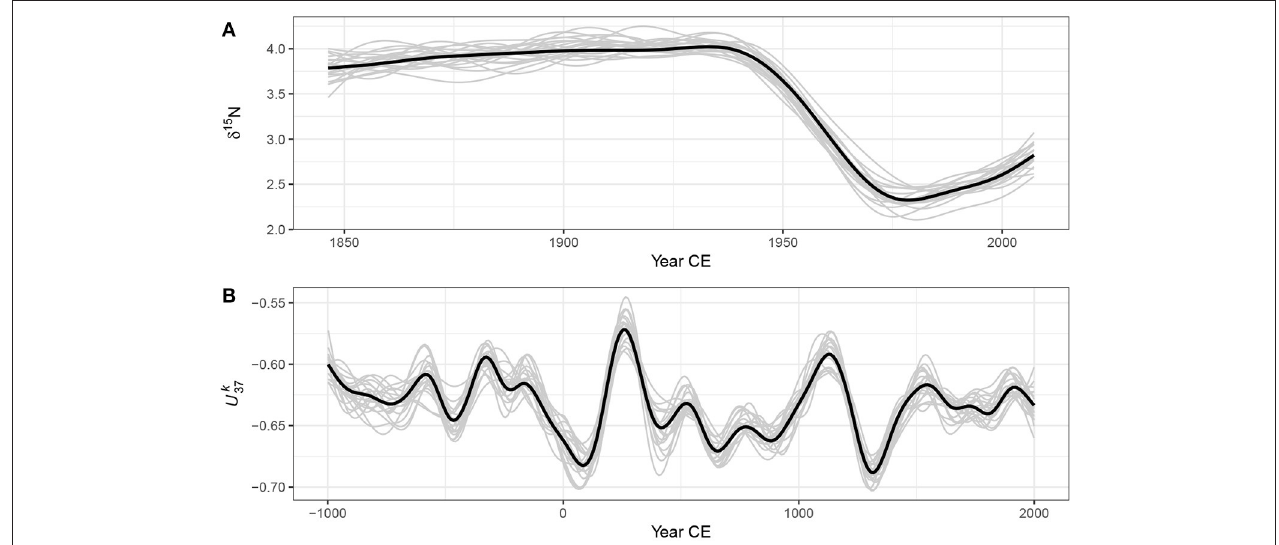
FIGURE 8 | Estimated trends (thick black lines) and 20 random draws (grey lines) from the posterior distribution of the GAM fitted to the Small Water δ 15 N (A) and Braya-Sø U K 37 (B) time